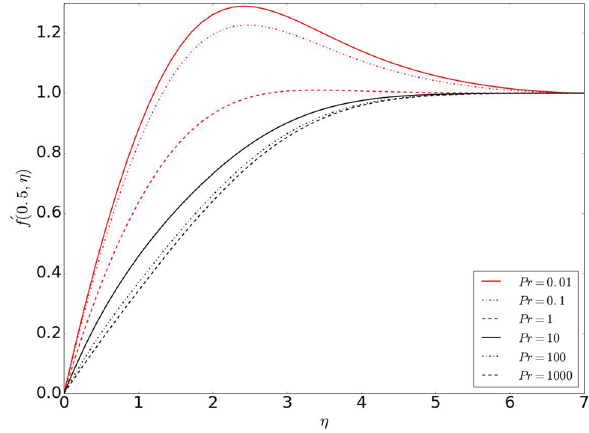
Fig. 16 Velocity Profile with various Pr with fixed 𝜉 = 0.5 and 𝜙 = 0.05 for Al 2 O 3 -water